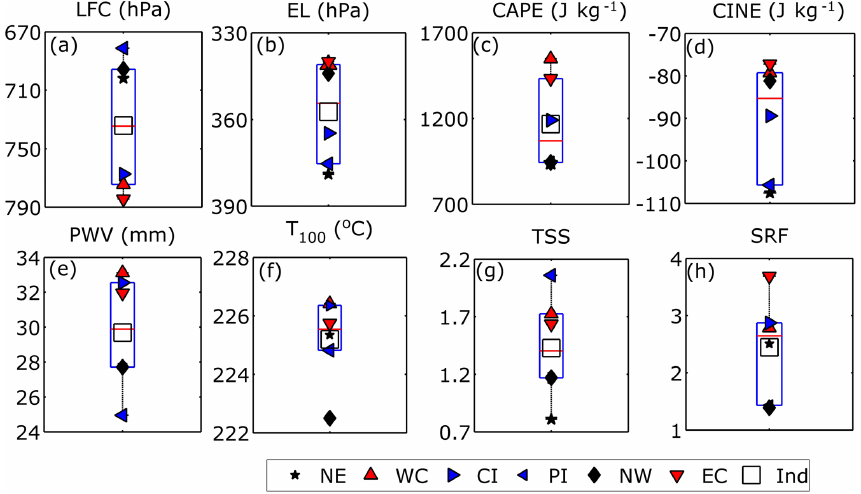
Figure 4. Climatological mean values of (a) LFC, (b) EL, (c) CAPE, (d) CINE, (e) PWV, (f) T 100, (g) TSS, and (h) SRF over the six subdivisions of India. Coastal regions are represented by red cones, the north-eastern and western regions are denoted by black stars and diamonds, and the blue cones represent the inland regions. Here the box limits refer to the upper and lower quartiles (25% and 75%), while the whiskers refer to the outlier limits of the data (5% and 95% limit of the